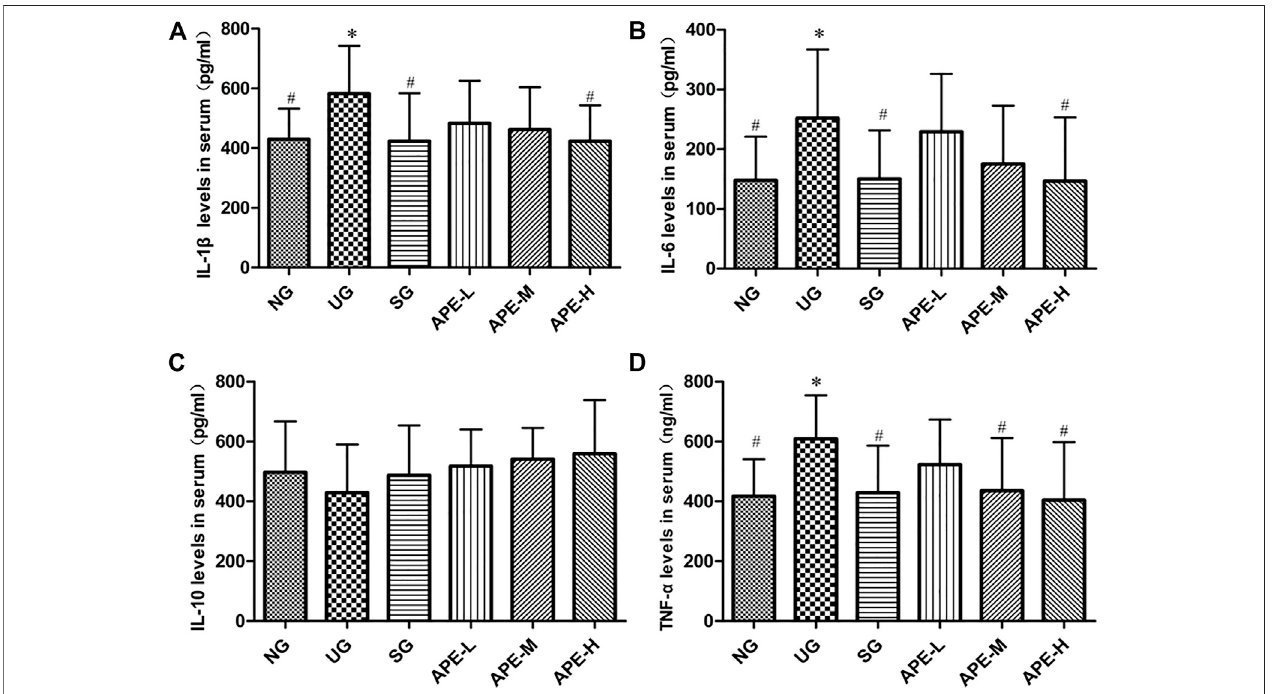
FIGURE7| EffectsofAPEontheserumlevelsofin fl ammatoryfactorsintheUCmice. (A) Interleukin-1 β (IL-1 β ). (B) Interleukin-6(IL-6). (C) Interleukin-10(IL-10). (D) Tumor necrosis factor- α (TNF- α ). n (cid:2) 8 for each group.* p < 0.05, ** p < 0.01 vs. the Normal group (NG). # p < 0.05, # # p < 0.01 vs. the UC model group (UG). APE, Alhagi pseudalhagi extract; UC, ulcerative colitis; IL-1 β , interleukin-1 β ; IL-6, interleukin-6; IL-10, interleukin-10; TNF- α , tumor necrosis factor- α ; NG, normal group; UG, ulcerative colitis model group; APE-H, high-dose APE group; APE-M, middle-dose APE group; APE-L, low-dose APE group.